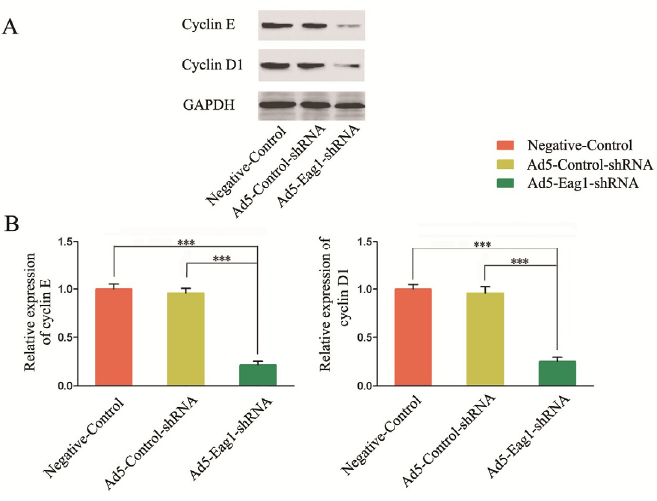
Figure 5. Regulation of cyclin D1 and cyclin E expression by Eag1-shRNA in MG-63 cells. ( A ) Representative blots showing significantly decreased expression of cyclin E ( n = 3) and cyclin D1 ( n = 3); ( B ) Densitometry analysis of cyclin E and cyclin D1 protein levels in MG-63 cells. GAPDH was the loading control. All data were normalized to the negative-control and presented as mean ± SD ( n = 3). *** p <